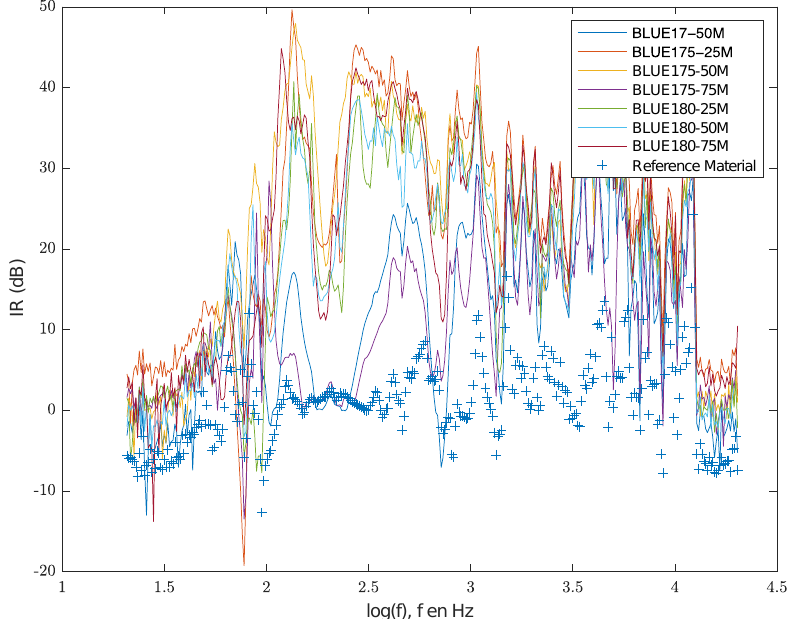
Figure 7. Reduction index of blue briquettes (lines) compared to the reference material (crosses). Volume 5.